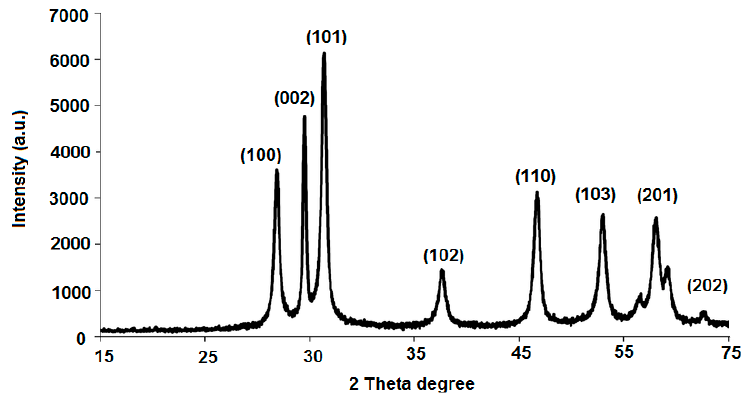
Figure 5. XRD pattern of sol–gel synthesized zinc oxide nanoparticles.